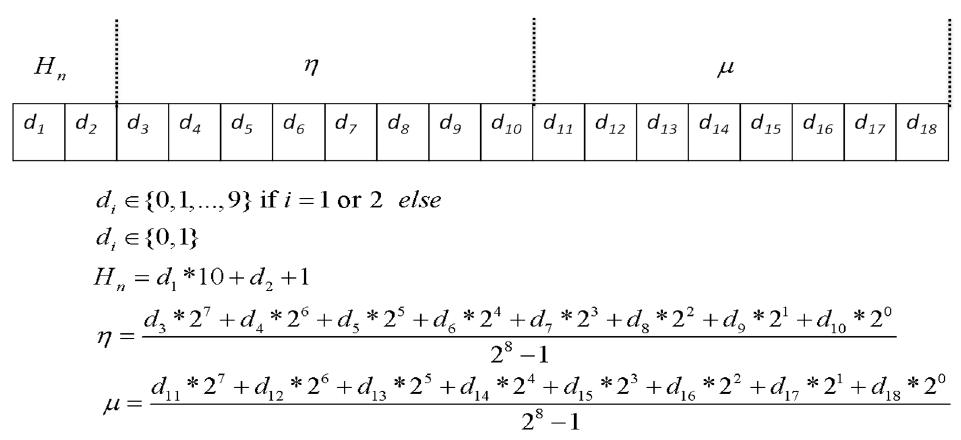
Figure 1. Learning encoding strategy for neural networks based on evolutionary algorithms.